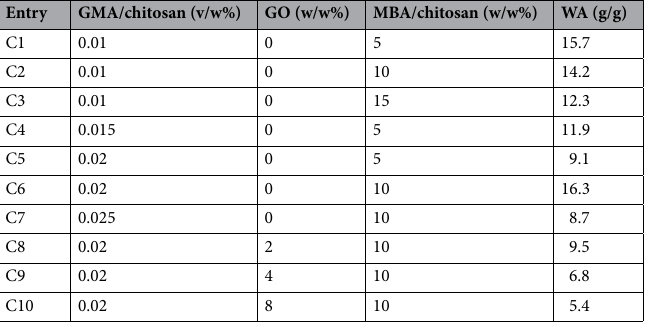
Table 2. Different CH-based hydrogel samples prepared via changing feeding ratios of GMA monomer, MBA cross-linker, and GO nano-filler and their water absorbencies.